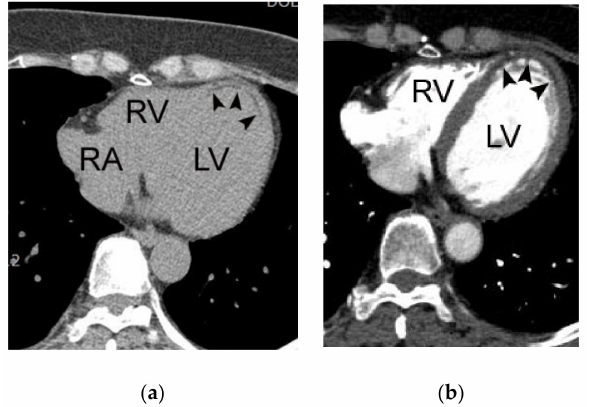
Figure 8. A case of chronic myocardial infarction in the left anterior descending coronary artery in a 63-year-old female patient. Note the subendocardial fat and myocardial thinning in the left ventricular apex (arrowheads in ( a , b )). RV, RA, and LV indicate right ventricle, right atrium, and left ventricle,